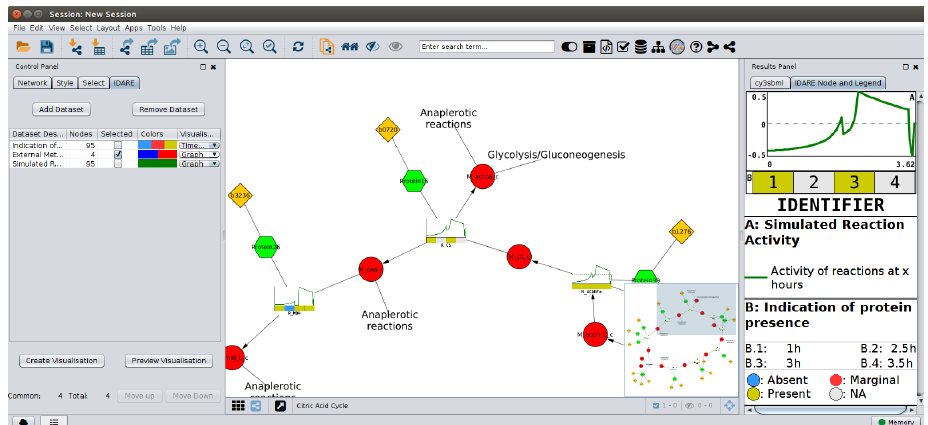
Figure 2. The interface of the app. On the left, the Data Management table provides an overview of available datasets and the currently selected properties for visualization. In the network window, the nodes with mapped images are displayed and on the right. The legend provides information about the visualization. Red circles represent metabolites, green hexagons proteins, and genes are represented as yellow rhombus. All reactions are replaced by metanodes in this